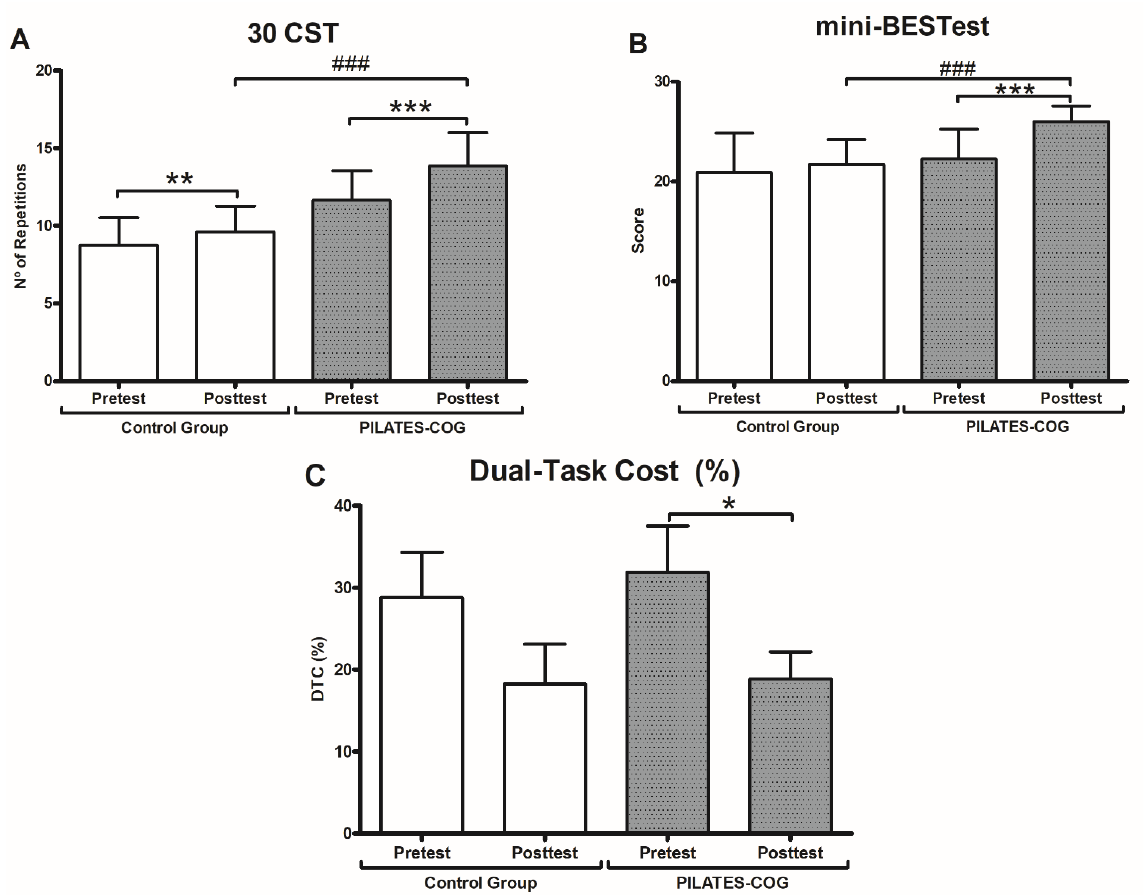
Figure 3. Physical functional performance. Values presented as mean ± SD. * = p < 0.05; ** = p < 0.01; *** = p < 0.001 (Pre × Post Test). ### = p < 0.01 (Post × Post Test). 30 CST = 30 s Sit-To-Stand Test. ( A ) Lower-Limb Muscle Strength. ( B ) Dynamic Balance. ( C ) Dual-Task Cost (%). For lower-limb muscle strength, main effects of time (F (1,35) = 34.093, p < 0.001, η p 2 = 0.493), group (F (1,35) = 39.675, p < 0.001, η p 2 = 0.531), and group x time interaction (F (1,35) = 7.839, p = 0.008, η p 2 = 0.161) were detected, which means that this variable changed